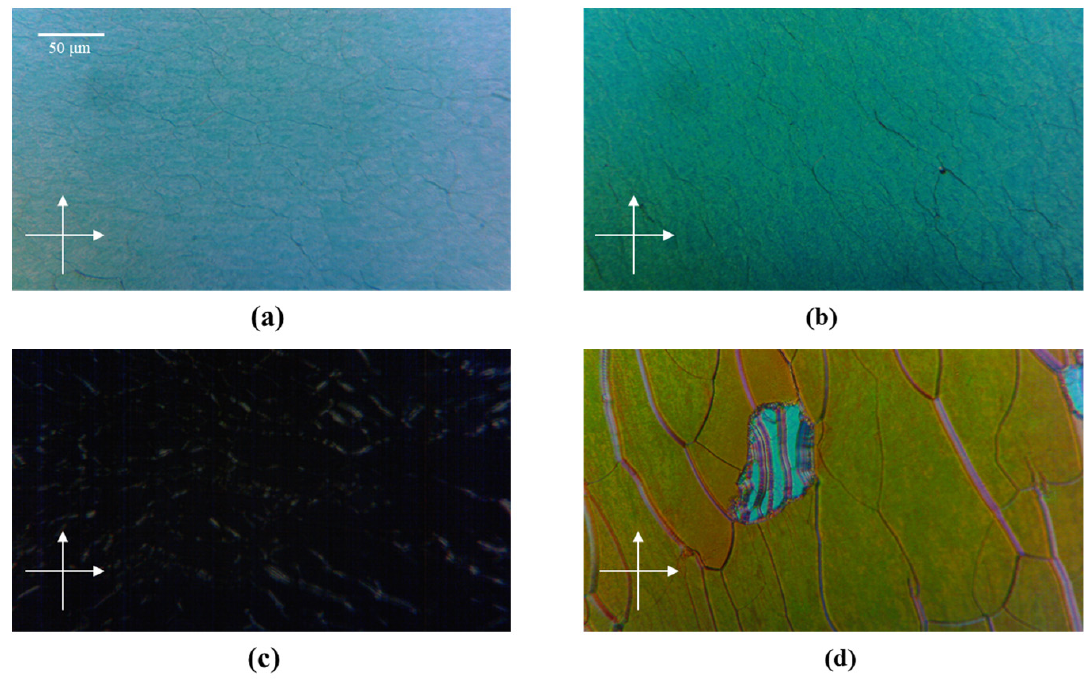
Figure 3. The polarizing optical microscopy images of samples at different preparation phases. ( a ) RH ‐ PCLC before UV exposure (Sample A), ( b ) RH ‐ PCLC after UV exposure (Sample B), ( c ) pure polymer network (Sample C), ( d ) polymer network refilled with the LH ‐ CLC (Sample D).